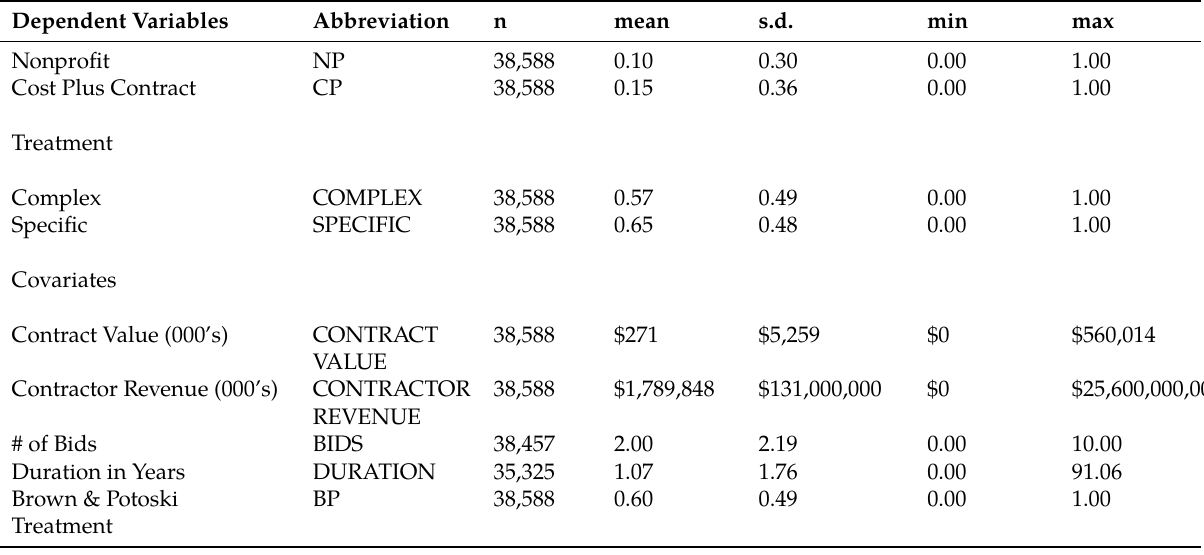
Table 5: Summary of